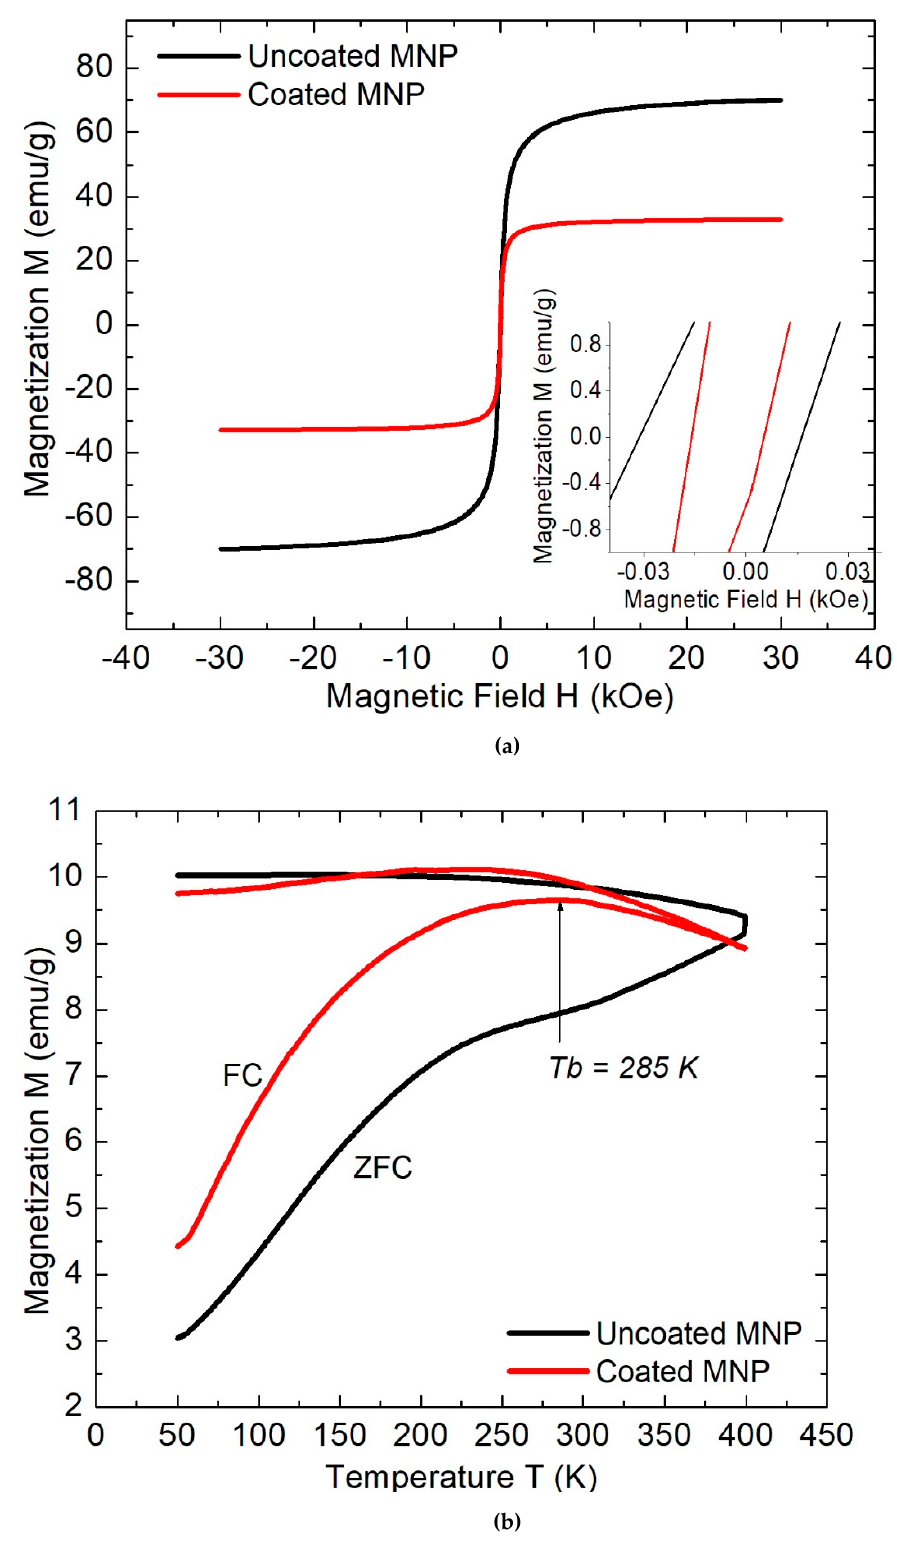
Figure 4. ( a ) Hysteresis loops of coated and uncoated MNPs and ( b ) their ZFC-FC plots.